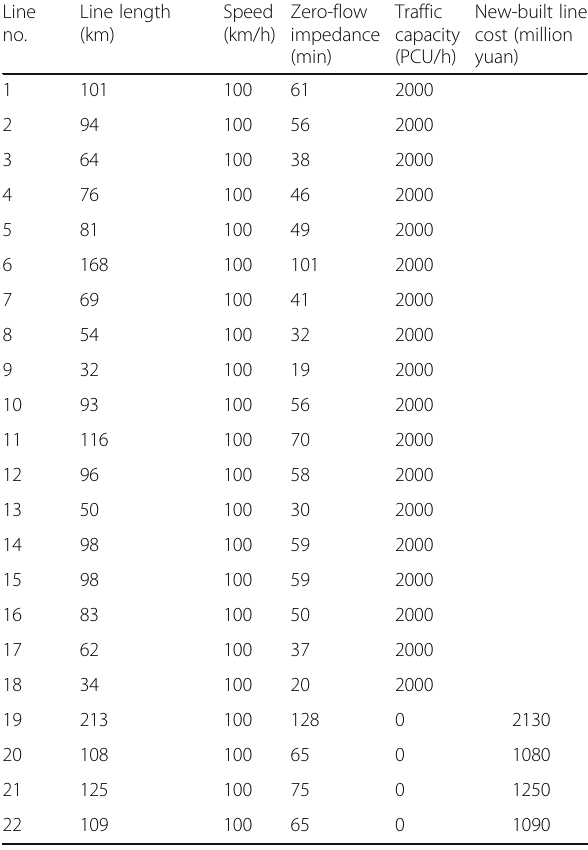
Table 3 Road section information in road network Line